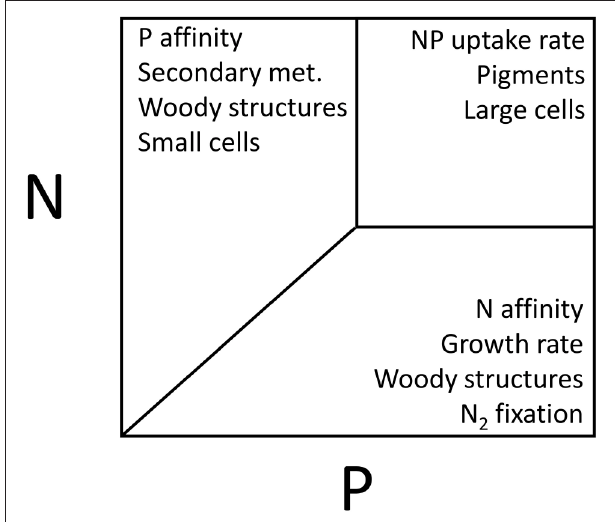
FIGURE 1 | Influence of N and Pavailabilities on trait dominance in autotrophs. Low N and P supplies will favor species with high affinities and may also facilitate synthesis of C-rich woody structures. Furthermore, species with C-rich woody structures may be facilitated by low N and P supplies. Furthermore, high N and P supplies will promote autotroph biomass and consequently self-shading, and thus may favor species with high pigment contents and/or species with accessory pigments.